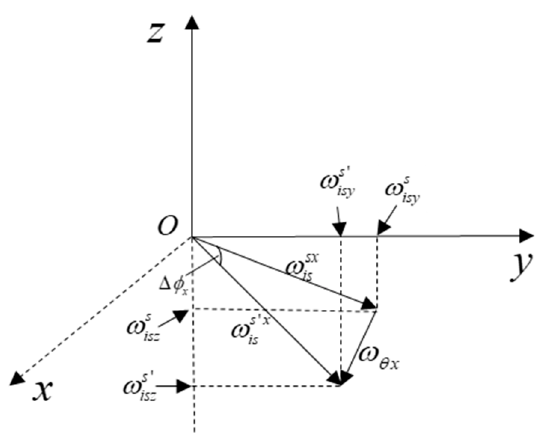
Figure 3. The - x axis coupling error angle.